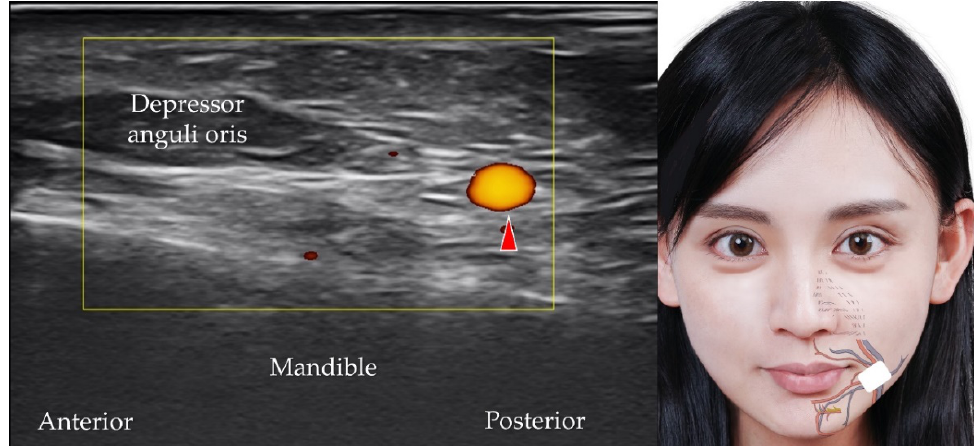
Figure 18. Power Doppler ultrasound imaging of the facial artery (red arrowhead) . White square , footprint of the ultrasound transducer.